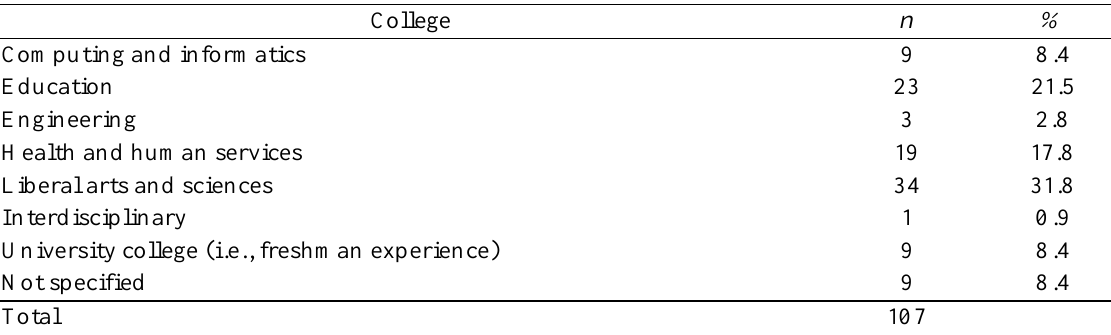
Faculty-Identified Reference Courses: Home College Within the